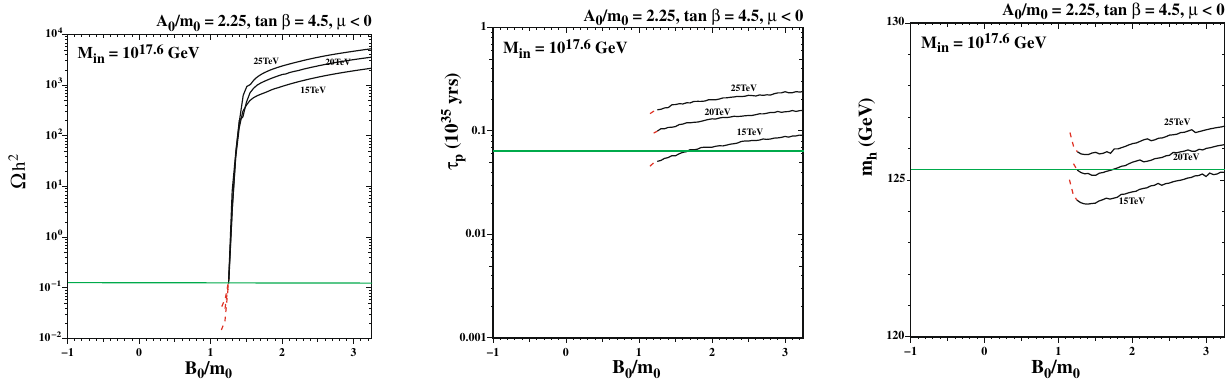
M in = 10 17.6 GeV